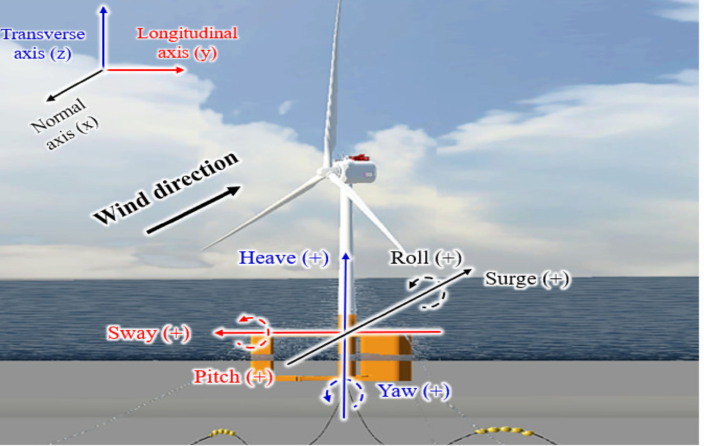
Figure 3. Configuration of the 10 MW FOWT with semi-submersible type platform and coordinate